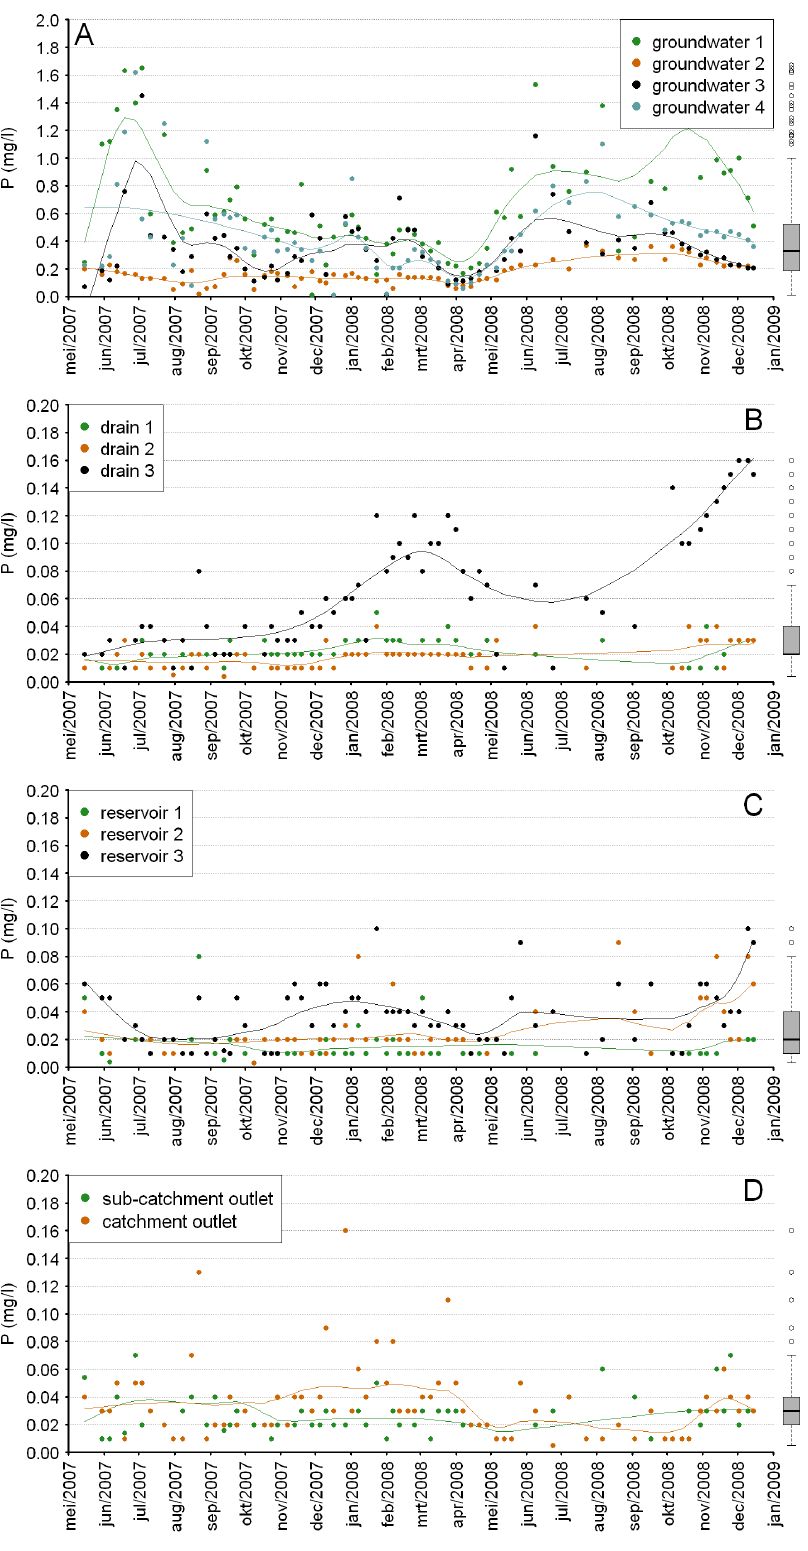
Figure 3. Time series and boxplots of dissolved total P concentrations of groundwater (a) , tube drain water (b) , in-stream reservoir water (c) and surface water (d) . (b) , (c) and (d) share the same y -axis. Remarks as for Fig.